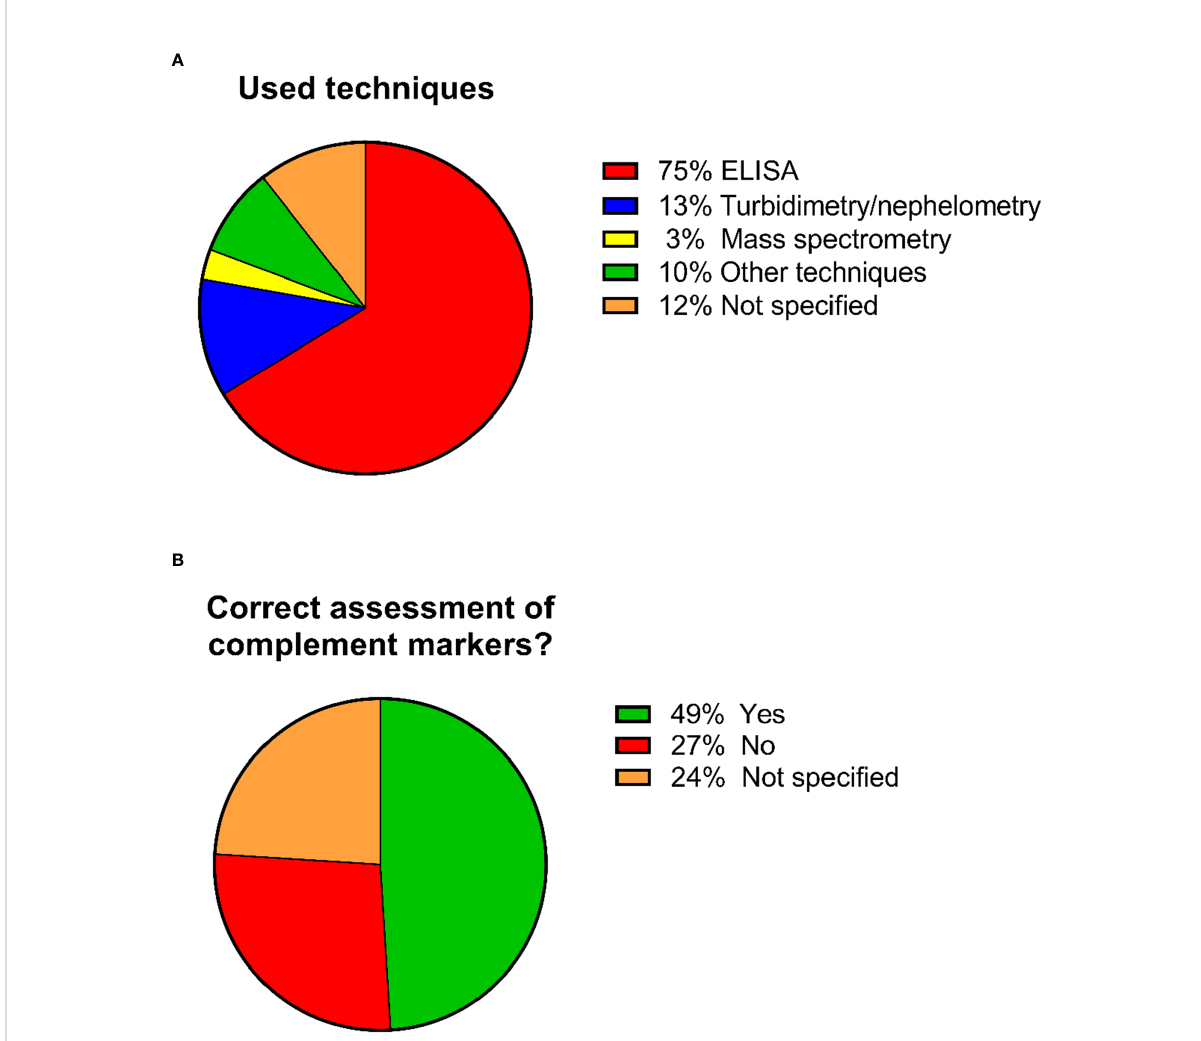
FIGURE 4 Pie charts showing the percentages regarding the used techniques and whether the correct sample types were used for complement assessment. A total of 92 studies were included in the analysis. (A) Percentages regarding the used techniques. Several studies used more than 1 technique for their measurements, hence the number of performed analyses is higher than the total number of the identi fi ed studies. (B) Percentages of studies that used/ did not used the correct sample type for complement